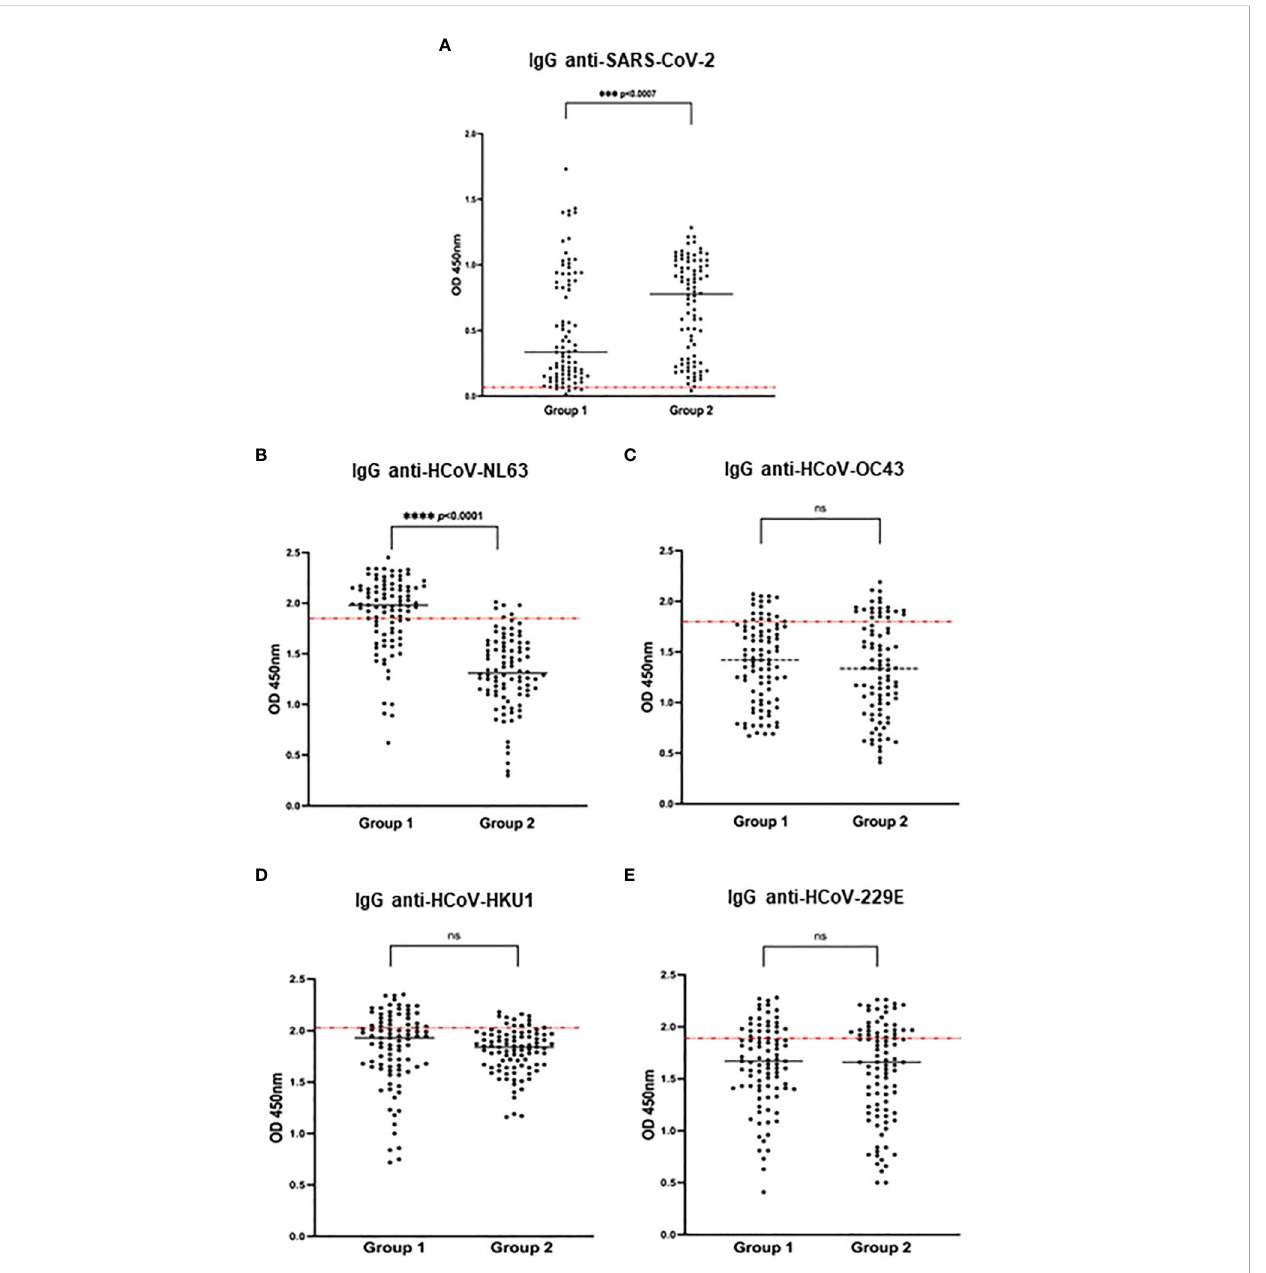
FIGURE 2 Seroprevalence of SARS-CoV-2 and HCoV in both patient groups (group 1: asymptomatic with positive SARS-CoV-2 serology, group 2: hospitalized COVID-19 patients). SARS-CoV-2 and HCoV N-speci fi c IgG antibodies were detected in the study participants' serum using an in-house ELISA. Results are represented by the OD units. The cut-off was determined by the mean OD + 2SD of 12 pre-pandemic samples and is indicated by the dotted red line in the individual fi gures. (A) IgG anti-SARS-CoV-2 (cut-off 0.06). (B) IgG anti-HCoV-NL63 (cut-off 1.85). (C) IgG anti-HCoV OC43 (cut-off 1.80) (D) IgG anti-HCoV-HKU1 (cut-off 2.03), (E) IgG anti-HCoV-229E (cut-off 1.89) Signi fi cances are indicated by p -values which were considered signi fi cant if <0.05. (ns, non-signi fi cant; *** p < 0.001, **** p <